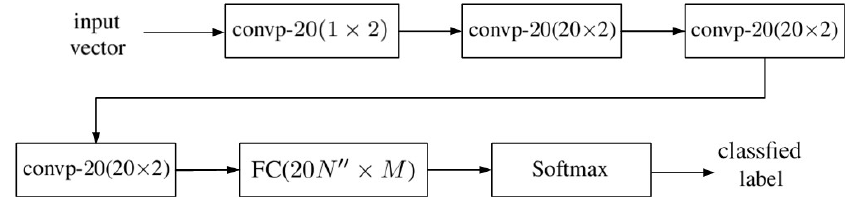
Figure 2. Schematic of a 1D convolutional neural network